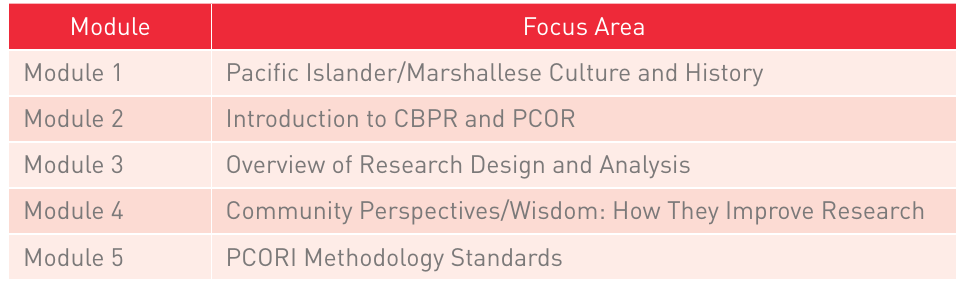
CERT Curriculum